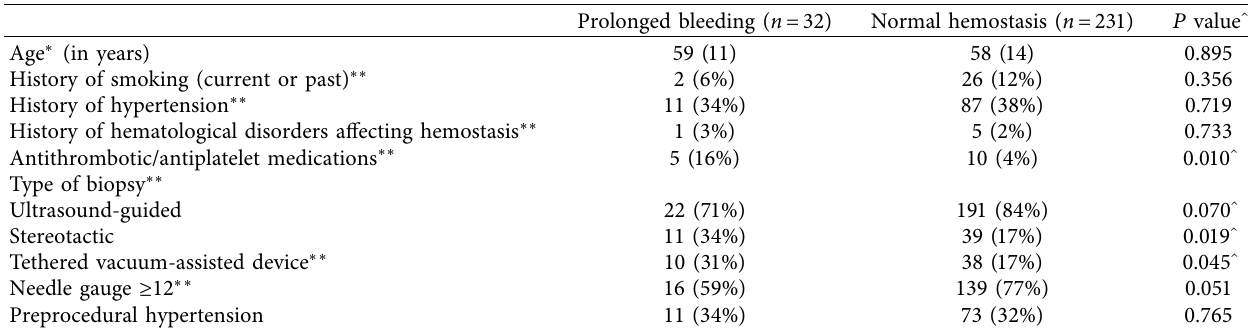
Table 3: Bivariate analysis of factors affecting postbiopsy bleeding time.